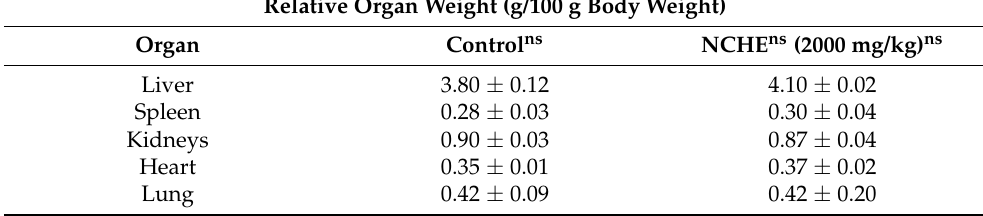
Table 5. Relative weight of the organs of the rats in the control group and treated with N. cochenillifera hydroethanolic extract (NCHE) in a single oral dose (2000